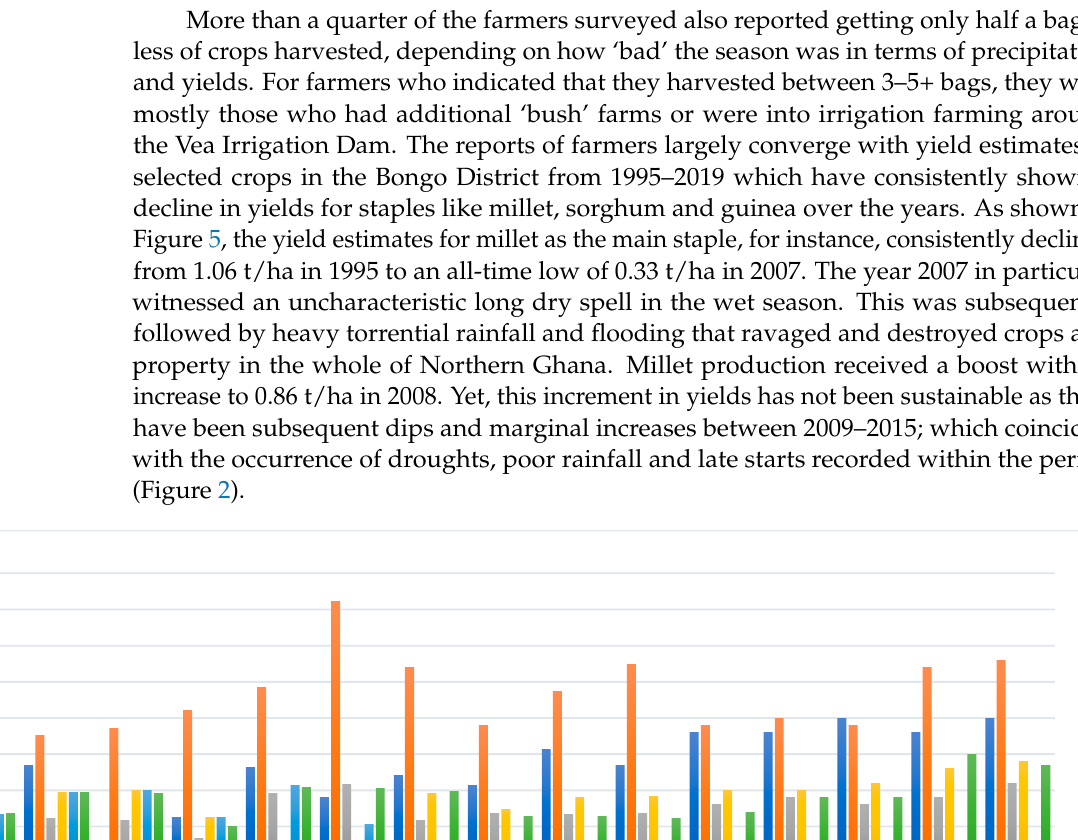
Figure 4. Average Harvest (per season) of Major Staples (in bags of 50 kg). Source: Composed from Field Survey Data (2016).